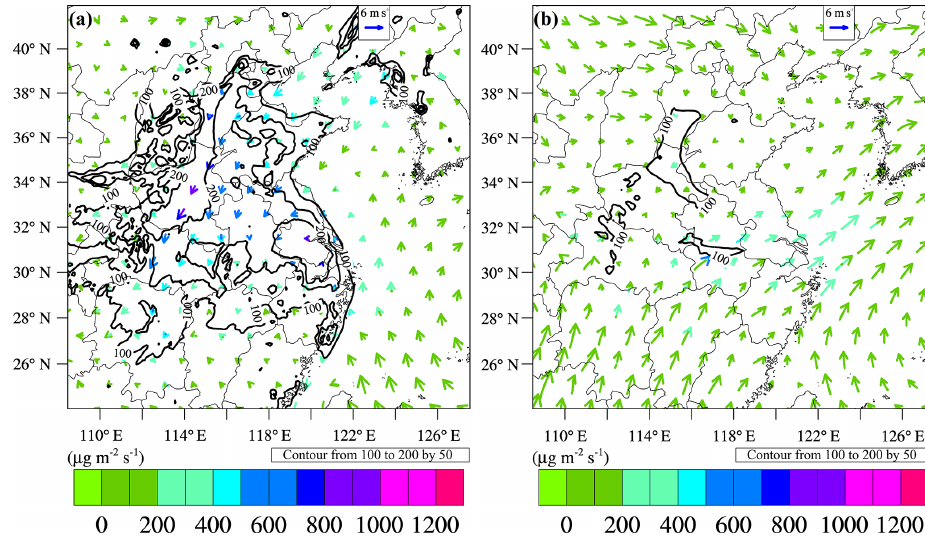
Figure 8. Averaged PM 2 . 5 flux (coloured arrows) and mass concentrations (black contour) at (a) the surface and (b) 1.0km altitude from 00:00LT 24 January 2015 to 00:00LT 27 January 2015.